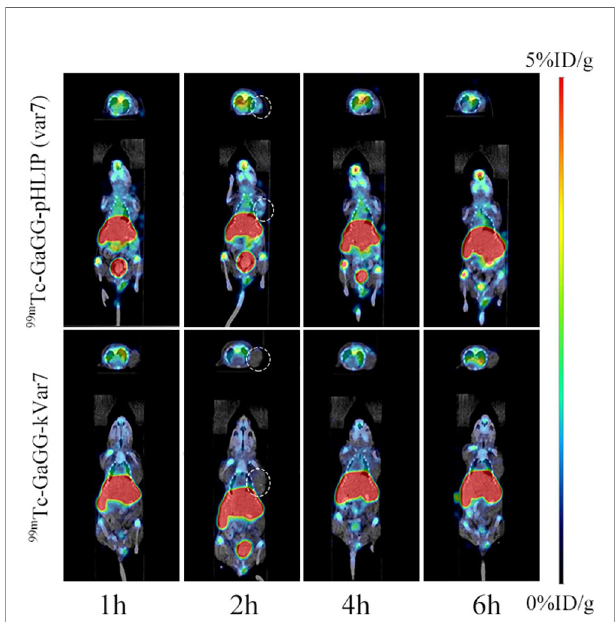
FIGURE 5 | SPECT/CT imaging of 99m Tc-pHLIP (Var7) and 99m Tc-kVar7 in the MDA-MB-231 tumor model